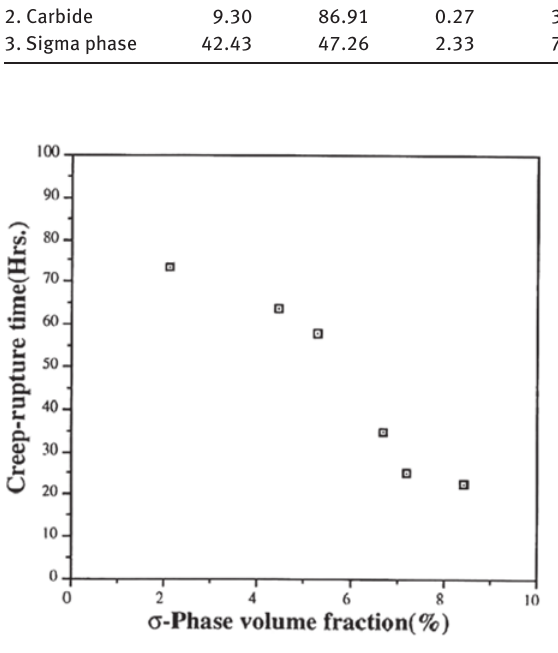
Fig. 2: Relationship between volume fraction of sigma phase and creep-rupture time in the HK40 tubes used for 90,000 hours